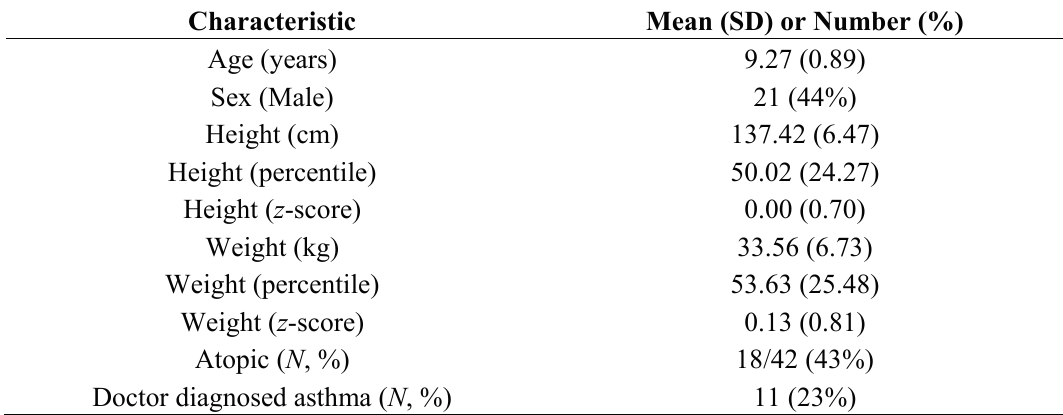
Table 1. Demographic and clinical characteristics of children recruited for the Ultrafine Particles from Traffic Emissions and Children’s Health (UPTECH) pilot study ( N =